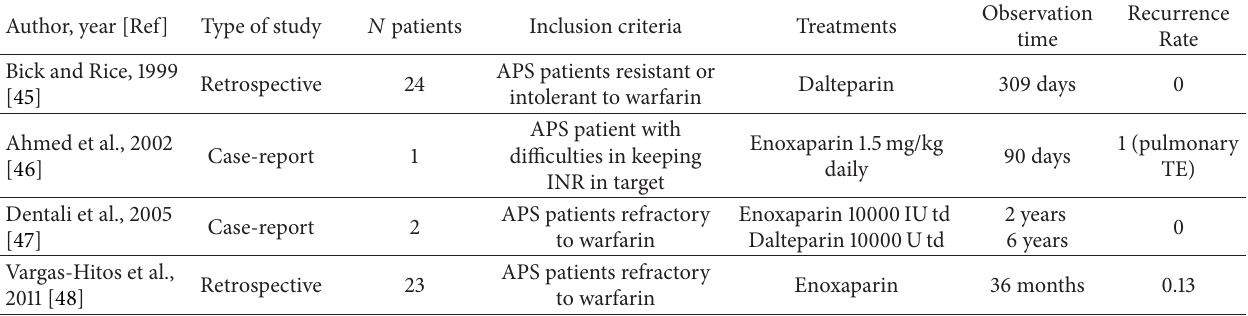
Table 2: Details of clinical studies investigating efficacy of long-term treatment with LMWH in resistant thrombotic APS. Author, year